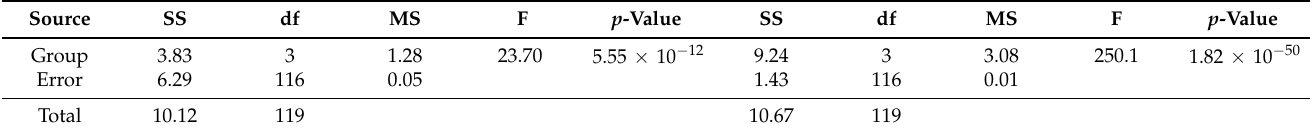
Table 6. ANOVA results of the left side columns are obtained from the ECG-based SVR-MF, ECG- based SVR-PS, ECG-based LSTM-MF, and ECG-based LSTM-PS models; ANOVA results of the right side columns are acquired from the ECG-based GBA-MF, ECG-based GBA-PS, ECG-based EGPR-MF, and ECG-based EGPR-PS, where SS is the sum of squares and df is the degrees of freedom. The total degree of freedom is 120 (=119-1) minus 1 from the total number of measurements